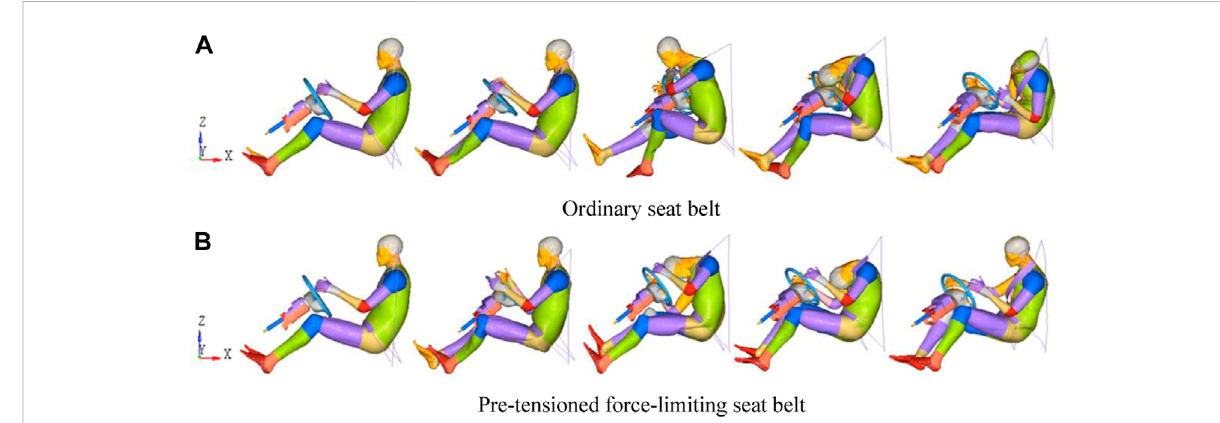
TABLE 2 Injury values for dummies ’ heads, necks, chests, and legs. Injury criteria Injury threshold Ordinary seat